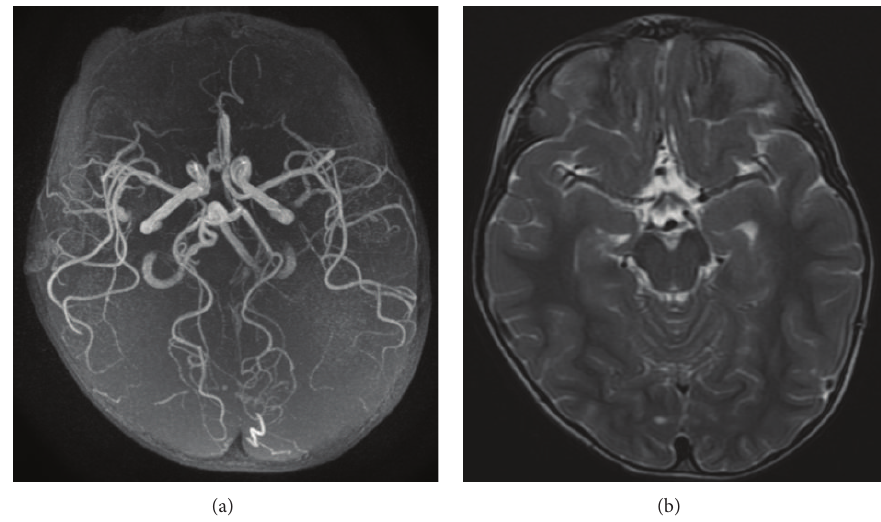
Figure 6: ((a) and (b)) Five-year follow-up MRA demonstrating no recanalization of the giant anterior communicating artery complex aneurysm and a permeable right